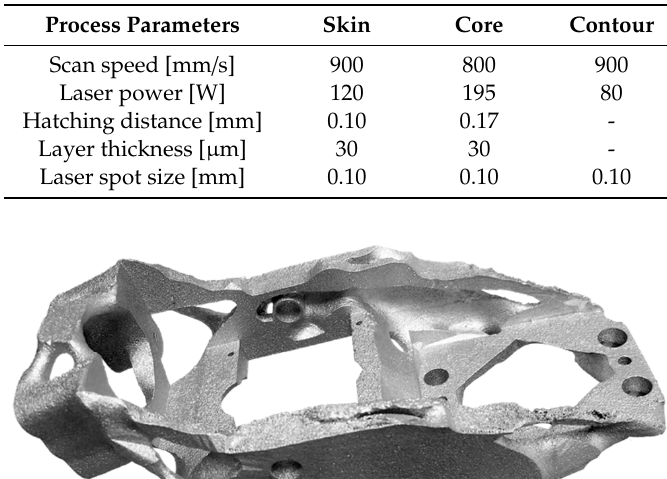
Table 2. Process parameter values employed for the bracket production.